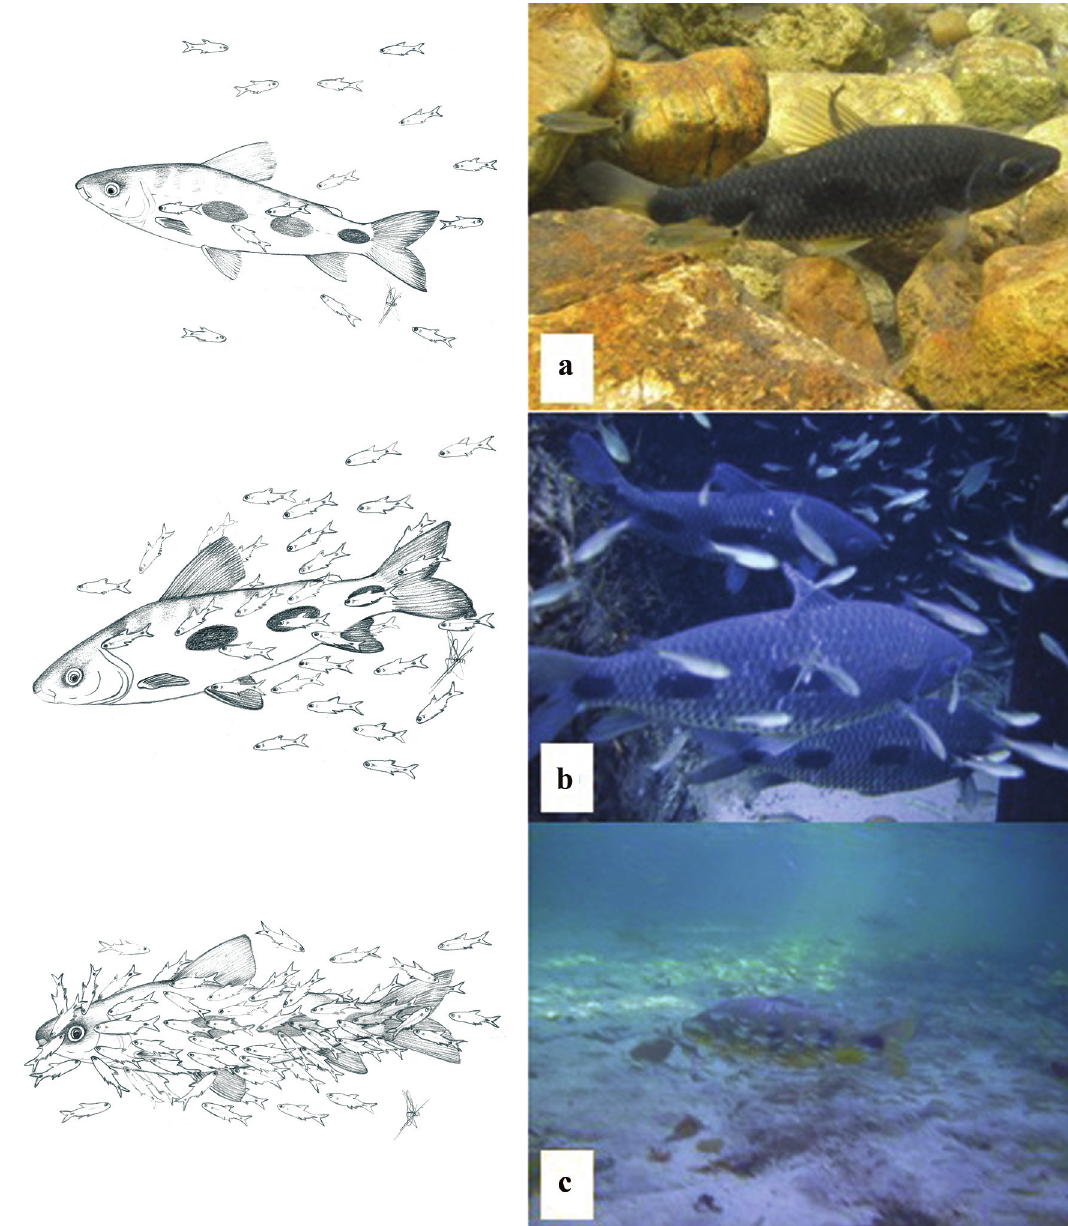
Fig. 2. Odontostilbe pequira attacks upon Leporinus friderici . a ) individual attack; b ) beginning of a group attack; and c ) group of O. pequira in a group attack. Drawings by Cristiane Freitas; photo (a) by Lucélia Carvalho; (b) and (c) by